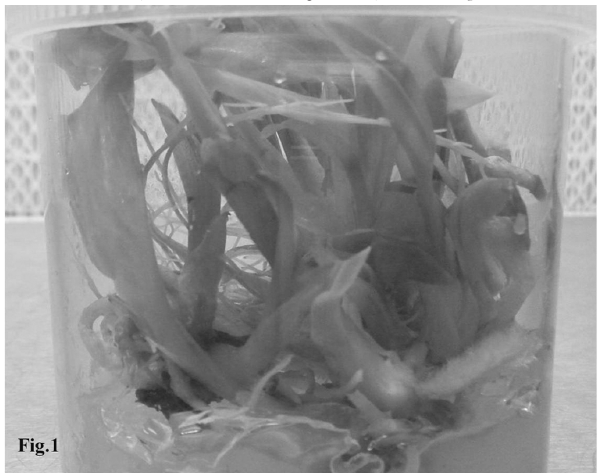
Fig. 1. Multiple shoots formation in 4 mg L -1 BAP + 1.0 mg L -1 NAA using 250 ml